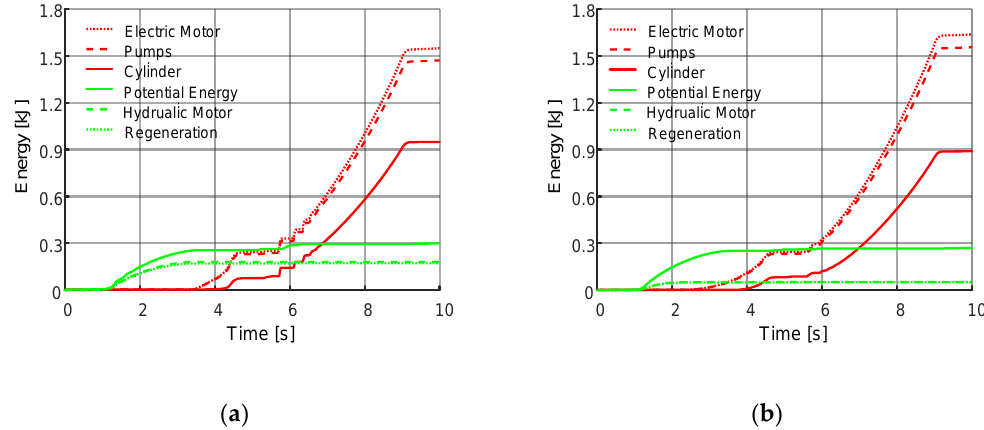
Figure 13. Energy consumption and regeneration: ( a ) SPC, ( b ) DPC.